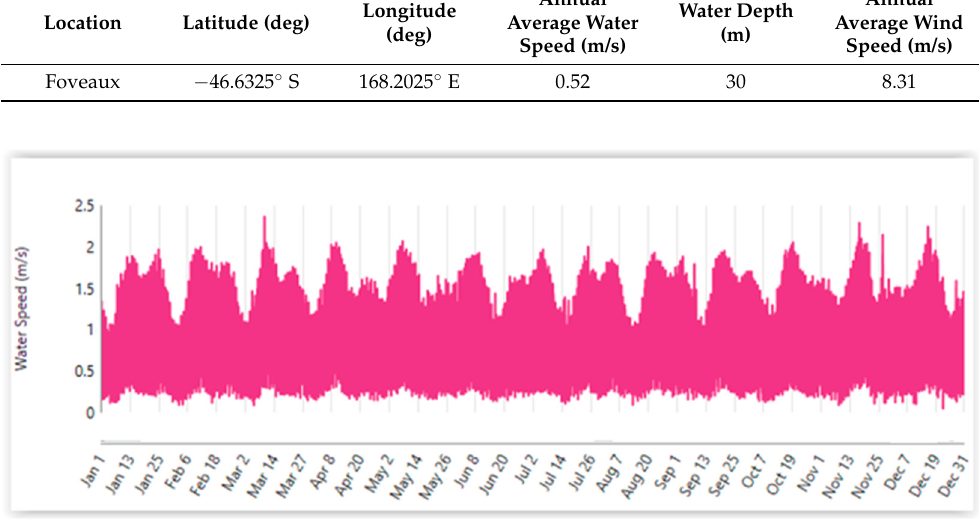
Figure 5. Annual water speed for Foveaux site.